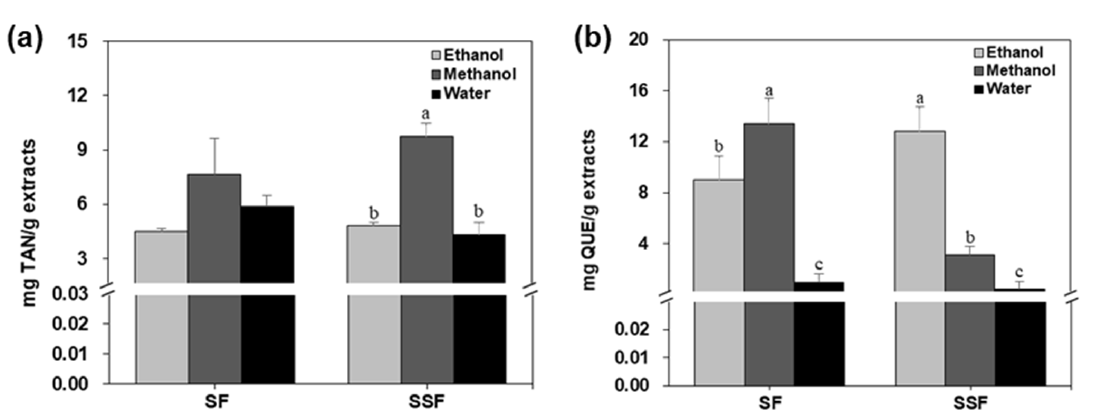
Table 2. The DPPH, ABTS, and FRAP IC 50 values of fresh and steamed Sargassum fusiforme ex- tracts.